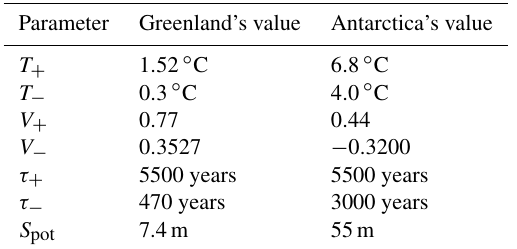
Table 6. Parameter values used here for Greenland and Antarctic ice